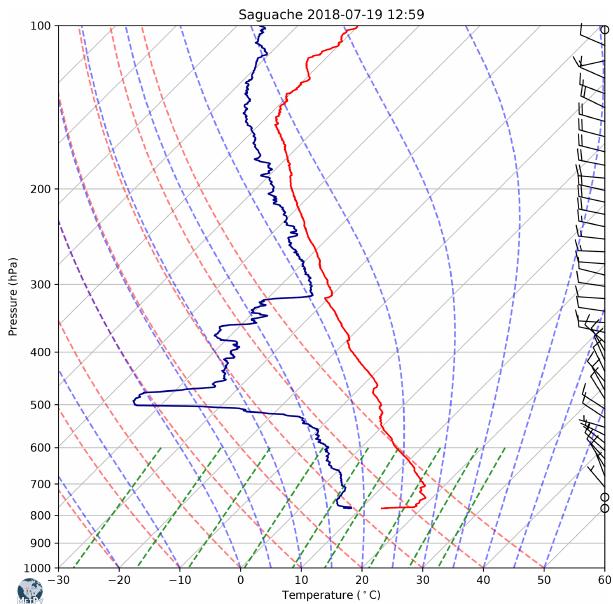
Figure 6. Sounding launched from near Saguache, CO, at 12:59UTC. Image created using MetPy (May et al., 2008–2020).